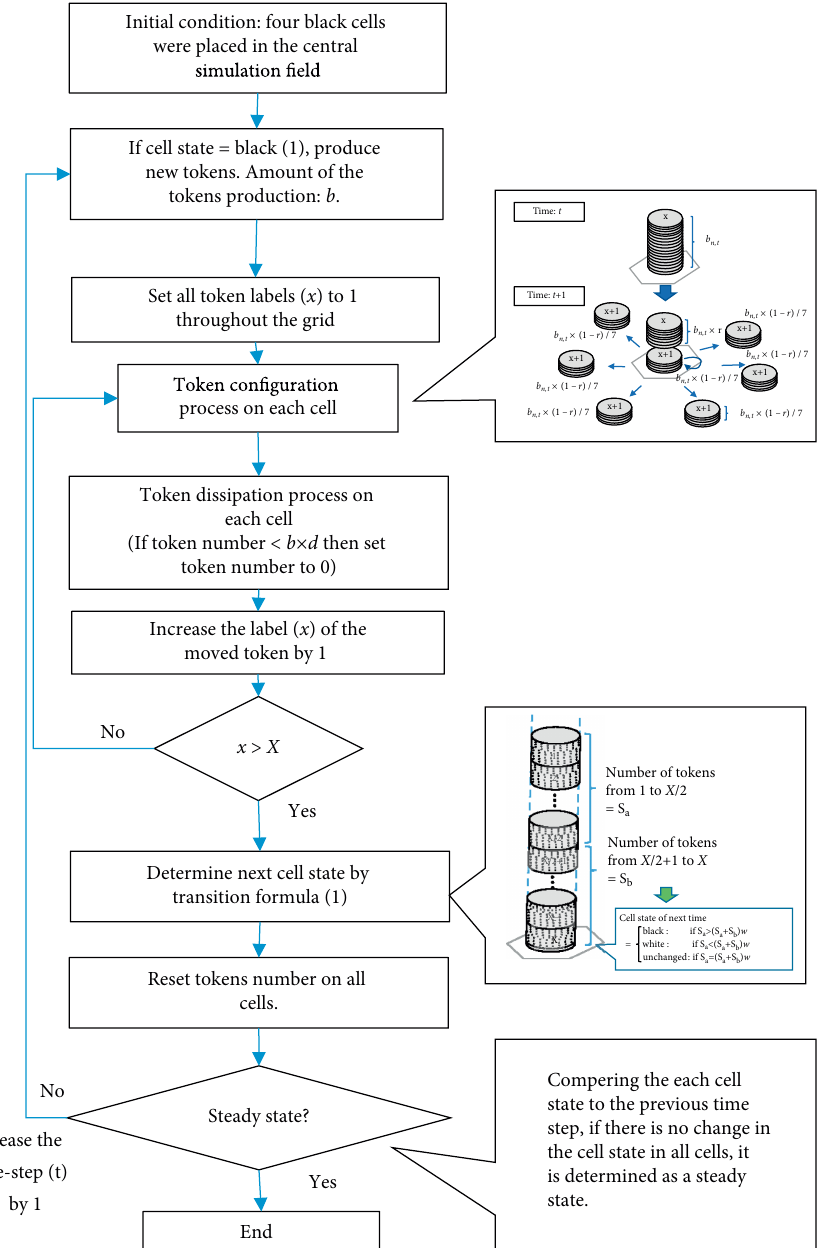
Figure 6: Flow chart of the calculations. (a) Two-state cells are assumed, namely, black ( state = 1) and white cells ( state = 0) . (b) Each cell can contain multiple tokens simultaneously. These are labeled with integer values. (c) The black cells are the source of the tokens. This is where the first parameter is set: the token production number 𝑏 is the initial number of tokens on a black cell at each time-step. (d) Some tokens are moved to adjacent cells. The residual token ratio 𝑟 is the fraction of unchanged (unmoved) tokens in each cell. The token distribution processes shown in Figure 4, are applied to each cell. In each cell, transit tokens have their integer labels changed from 𝑥 to 푥 + 1 . Under this process, some tokens remain in their original cell without modification. Incremental labeling is repeated until the maximum label number reaches 𝑋 (where 𝑋 is an fixed even integer). (e) Using the token dissipation rate 𝑑 , the number of tokens in a cell is set to zero if there are fewer than 𝑏 × 𝑑 tokens. (f) Processes (c), (d), and (e) are applied to all cells in the hexagonal grid and the state of cells at the next time-step is determined. (g) After the movement and modification of the tokens, each subsequent cell state is determined by the ratio of the number of tokens labeled 푋/2 or smaller in the cell to the total number of tokens in the cell, according formula